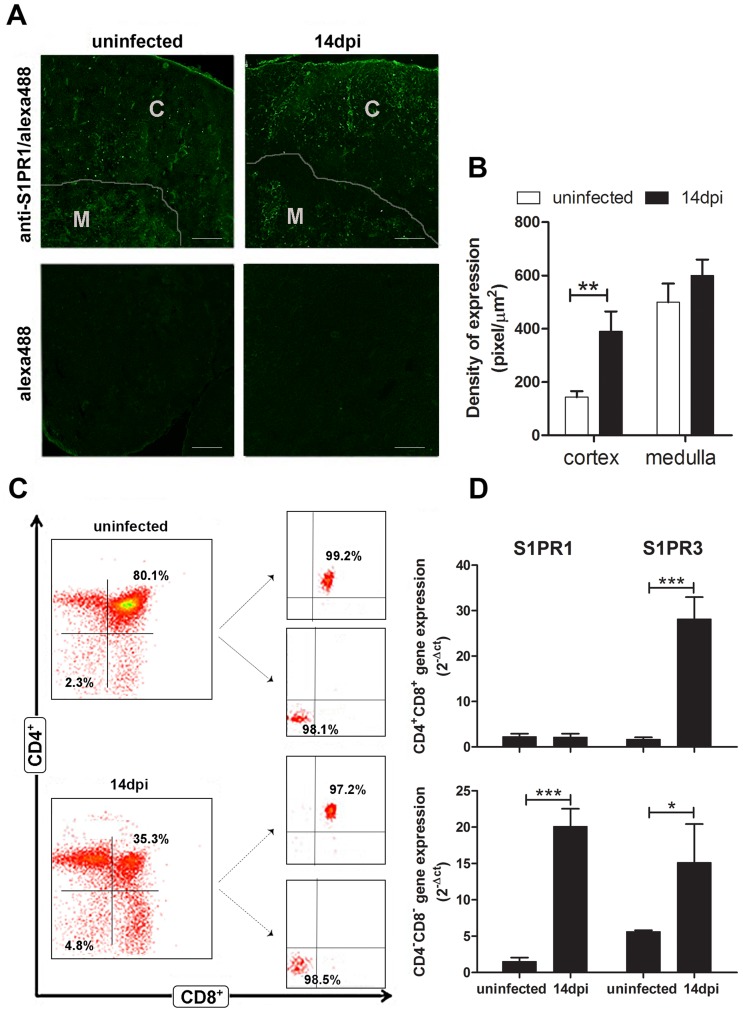

T. cruzi acute infection increases expression of S1P receptors in CD4−CD8− thymocytes and thymic cortical compartment.(A) Thymuses were stained with anti-S1PR1 monoclonal antibody and analyzed by immunofluorescence. Representative confocal microscopy fields of thymuses stained with anti-S1PR1 monoclonal antibody and goat-anti rabbit alexa-488 secondary antibody are shown in (upper left) normal thymus and (upper right) atrophic thymus at day 14 post-infection. The respective staining controls without the primary antibodies are shown in (lower left) and (lower right). Scale bar = 100 µm. (B) Graphs correspond to relative quantitation analysis of S1PR1 deposition from 5 microscopic fields of thymuses from control (n = 3) or infected animals (n = 3). It is clear the increase in S1PR1 within the cortex of thymic lobules from infected animals. (C) CD4−CD8− and CD4+CD8+ T cells from normal and acutely-infected mice (14 dpi) were purified from thymus, by cell sorting using flow cytometry to assess the transcriptional levels of S1P receptors. Plots show the high purity of isolated CD4−CD8− and CD4+CD8+ T cells (>95%). (D) Total mRNA from purified CD4−CD8− and CD4+CD8+ T cells were processed for RT-PCR. The results represent the amount of transcripts, depicted in relation to the housekeeping gene GAPDH as 2−ΔCt. There is a significant increase in the contents of both S1PR1and S1PR3 transcripts when comparing control versus infected CD4−CD8− T cells, whereas only S1PR3 transcripts increased in the CD4+CD8+ T subset relative to the controls. Data are means ± SE of two independent experiments using six mice per group. Differences between control and infected mice are significant * (p<0.05), ** (p<0.01) and *** (p<0.001).